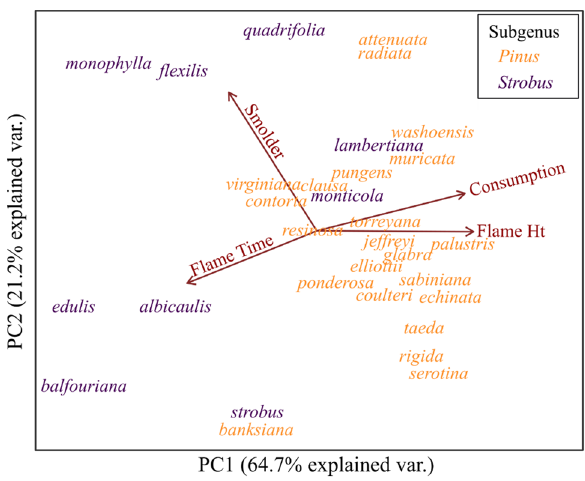
Figure 2. Principal component analysis of the flammability of 31 North American pine